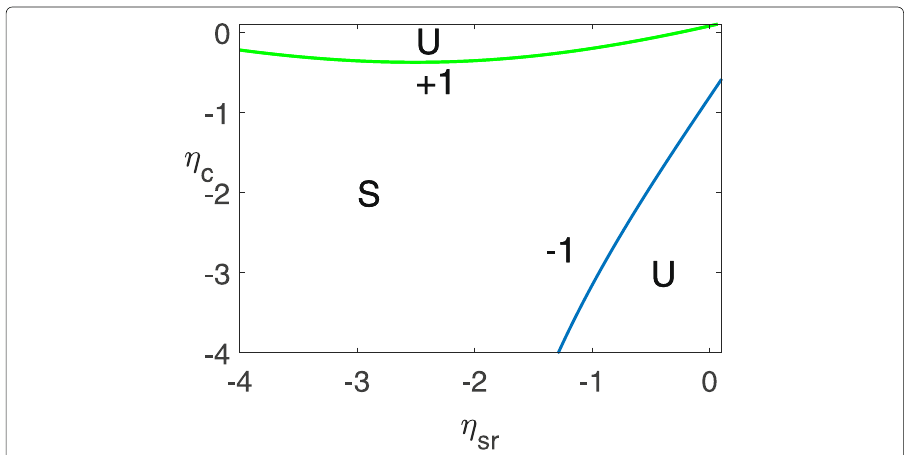
Fig. 8 Zero-contour of the MSF in the (η c , η sr ) plane for T p = 0.6. Note that both η c and η sr are real since we focus on diffusive couling. The MSF is negative in the region labeled S and positive in regions denoted by U. The green curve corresponds to saddle-node bifurcations ( + 1), while the blue curve refers to period-doubling bifurcations ( −